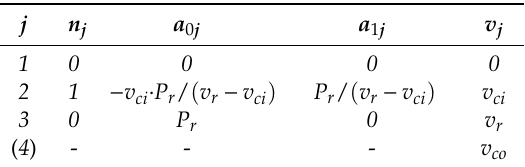
Table 1. Relationship among parameters of the linear models and the parameters of the wind turbine